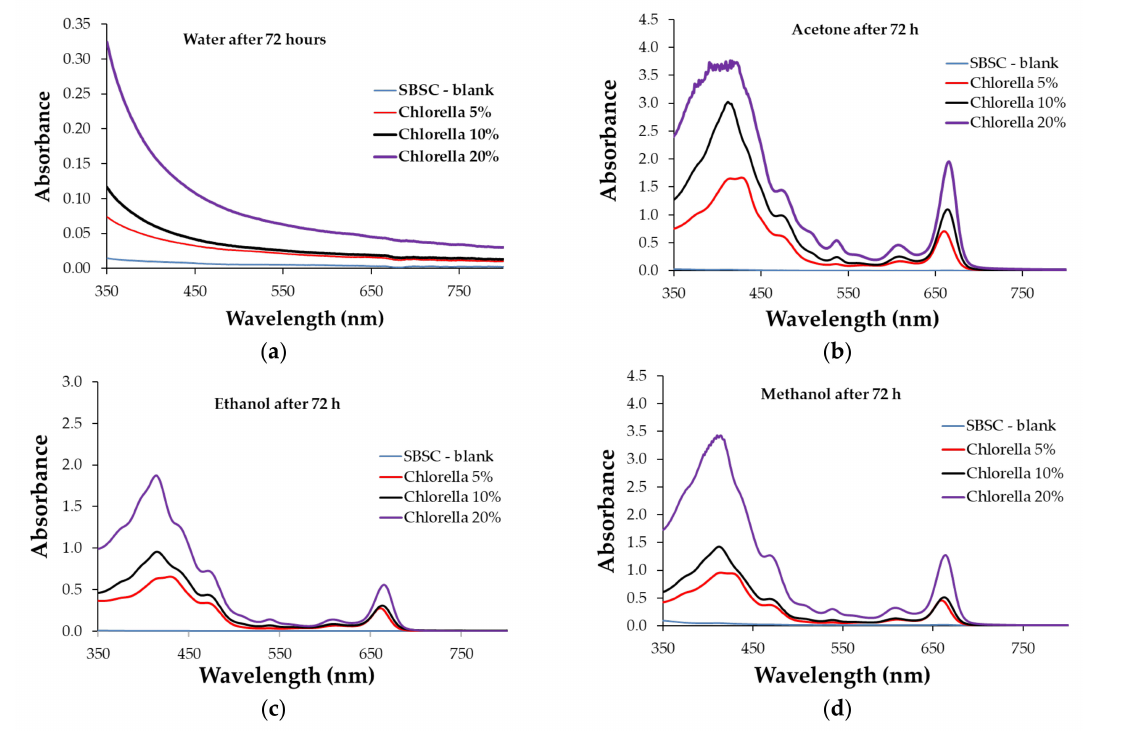
Figure 11. UV-Vis spectra for extraction solutions (swelling tests) after 72 h of contact with Chlorella